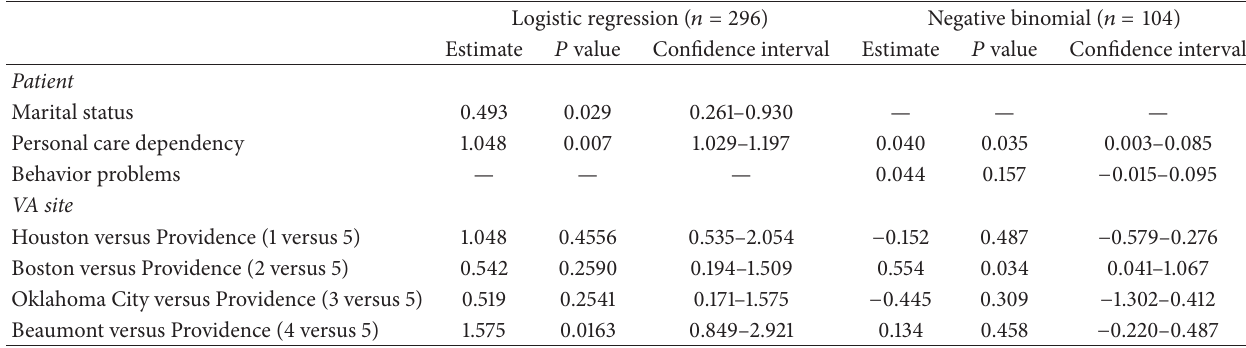
Table 6: Multivariate analysis ∗ of predictors of veterans’ utilization of inpatient hospitalization ( 𝑛 = 195